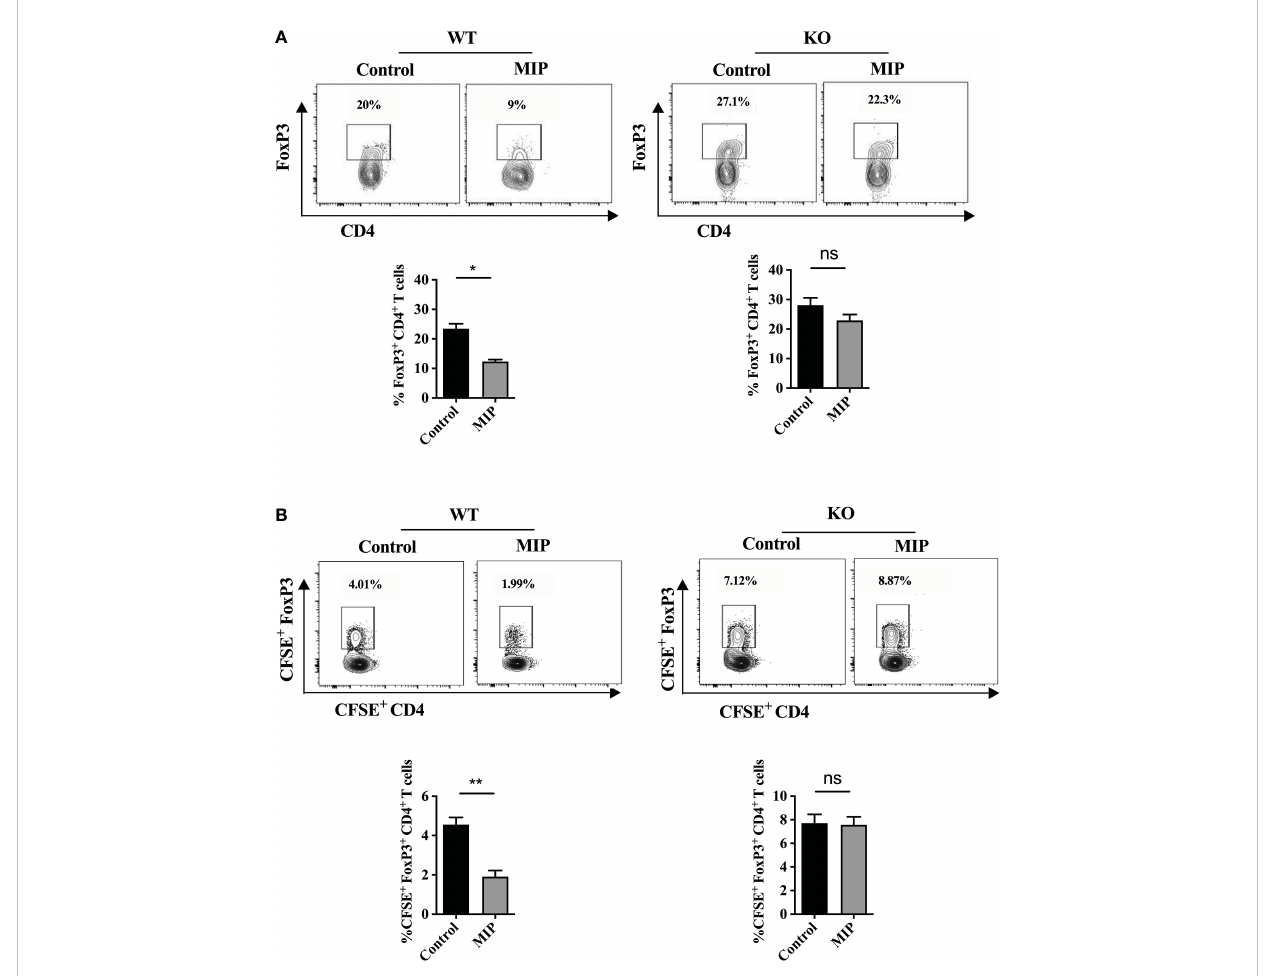
FIGURE 7 Role of type 1 IFN in regulation of in fi ltration of Tregs into the MIP treated TME: (A) The percentage of Tregs in IFNR1 -/- /wild type mice in tumors treated with or without MIP. (B) Tumor bearing wild type and IFNR1 -/- animals, 24 hours after the third dose of MIP, received an intravenous transfer of CFSE-labeled splenocytes of healthy wild type donor mice. Tumors were resected 18 hours after transfer, followed by fl ow cytometric analysis of intratumoral CFSE + Treg cells. Proportion of CFSE + CD4 + FoxP3 + Tregs within the total live CFSE + cells was analyzed in the tumor of untreated/MIP treated mice. Flow cytometry contour plot is shown for one representative mouse per group. The bar graphs represent average of 5 mice per group. The results are expressed as mean ± SEM. Statistical analysis was performed using unpaired Student ’ s t test (*:p<0.05, **:p<0.01, ns, non-signi fi cant). Each experiment was repeated three times independent of each